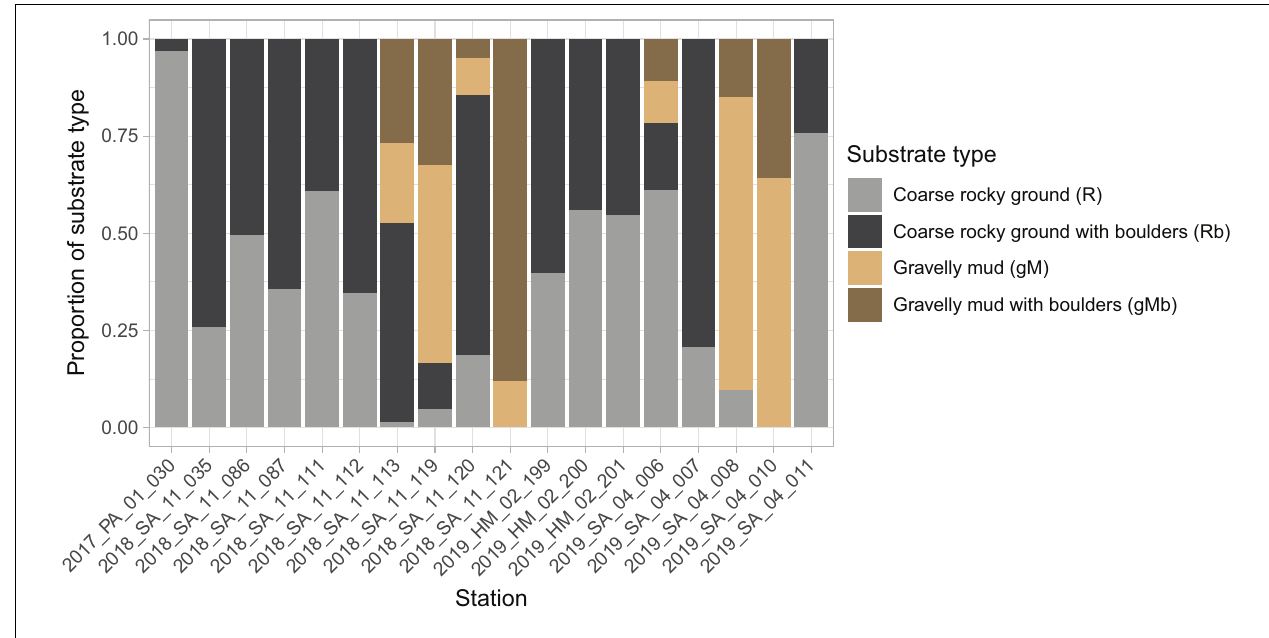
FIGURE 7 | Stacked bar chart showing proportion of each substrate type in images from each station. Substrate classes are based on the revised EUNIS Habitat Classification (Davies et al., 2004), as adapted by Gougeon et al. (2017) and further modified for the purposes of this study.